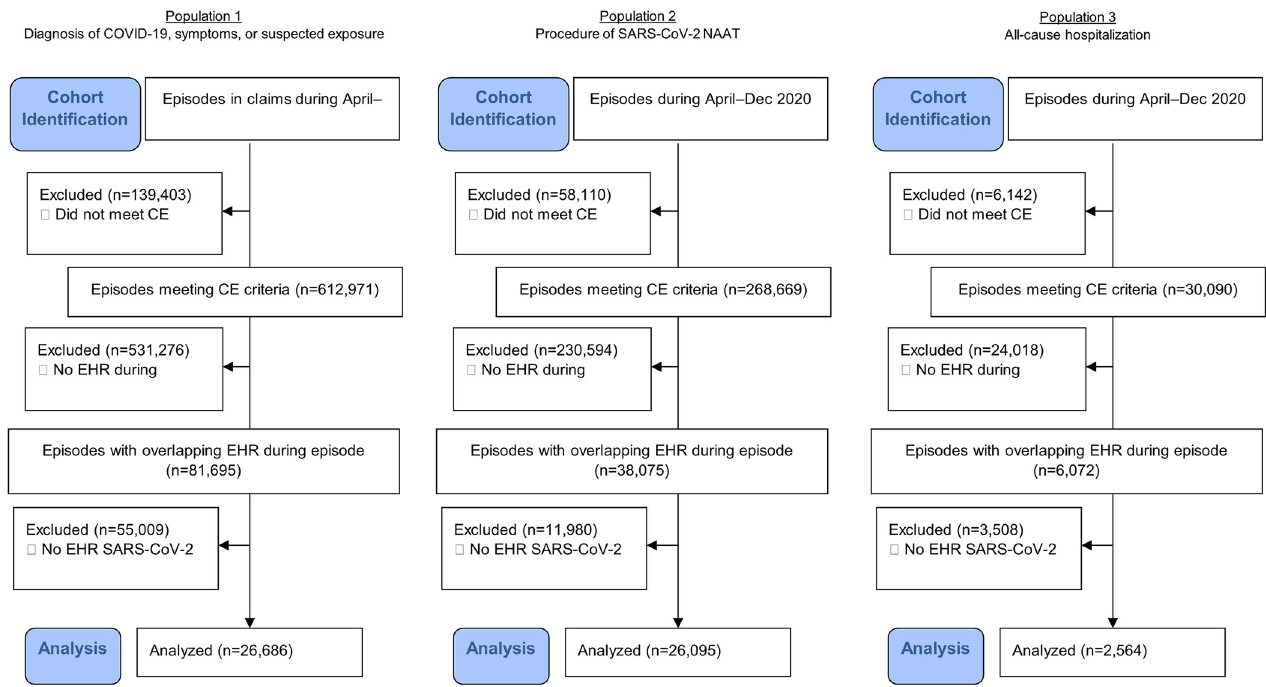
Fig 2. Cohort flow diagram for the commercially insured population in CED. CE criteria: Individuals must be continuously enrolled with medical benefits during the episode and during the 6-month baseline period prior to the episode. An enrollment gap of up to 31 days was allowed. CE continuous enrollment, CED IBM 1 MarketScan Explorys Claims-EMR Data Set, EHR electronic health record, NAAT nucleic acid amplification test, SARS-CoV-2 severe acute respiratory syndrome coronavirus 2.